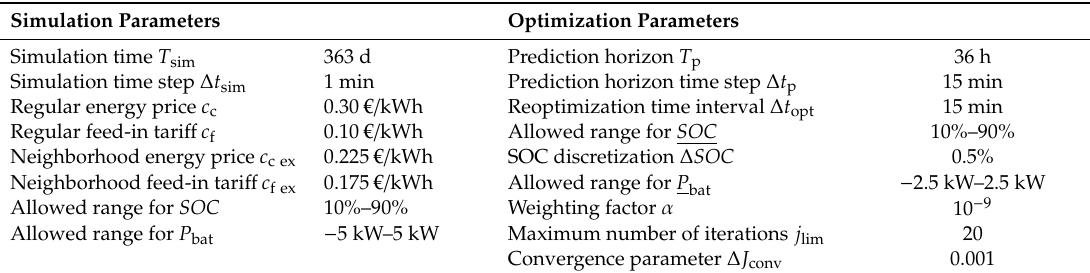
Table 5. Simulation and optimization parameters.